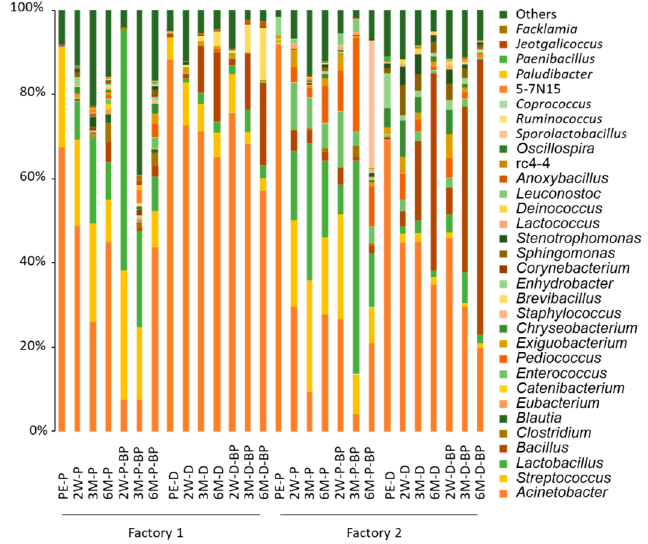
Figure 1. Genus-level bacterial microbiota in soybean curd residue silage prepared with prompt and delayed sealing and with and without beet pulp addition. PE, 2W, 3M, and 6M indicate pre-ensiled material and silage stored for 2 weeks, 3 months, and 6 months, respectively. P, D, and BP after the hyphenation denote prompt sealing, delayed sealing, and beet pulp addition, respectively.